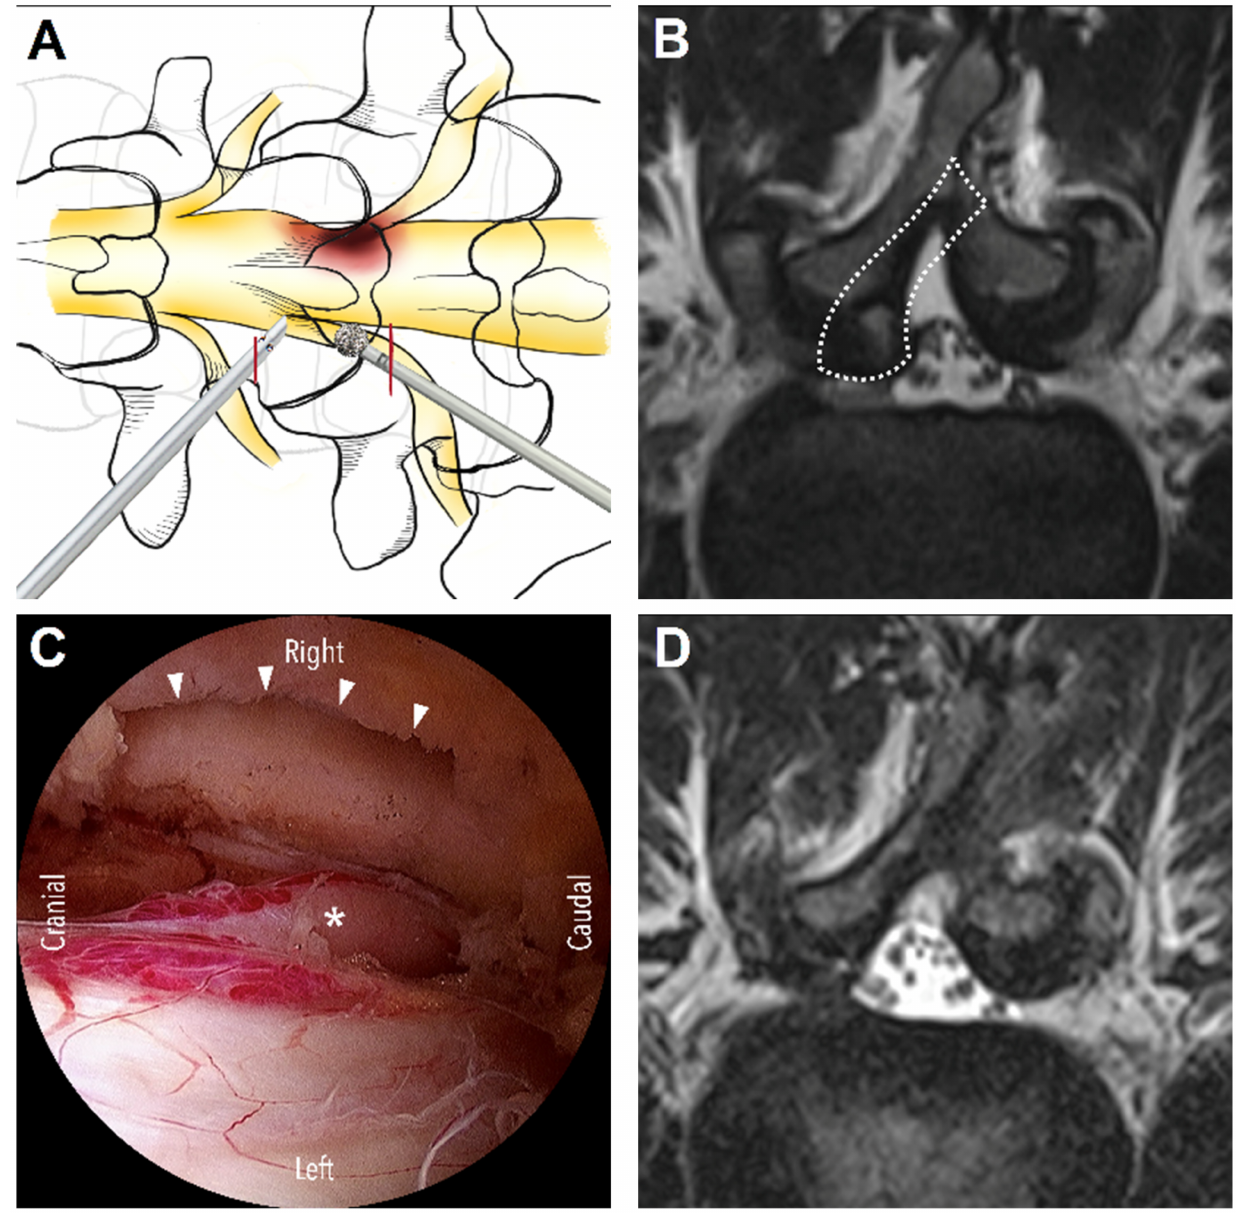
Figure 2. The contralateral approach. ( A ) The schematic diagram illustrates the skin incisions (red lines) and initial target area of decompression from the left side: the junction of spinous process and lamina. ( B ) Pre-operative MRI shows isolated lateral recess stenosis and contralateral decompression via an opposite interlaminar window (dashed line area). ( C ) The endoscopic view demonstrates the facet joint viewed from inside the spinal canal (white arrow heads), decompression of the lateral recesses, and the traversing nerve root (white asterisk). ( D ) Post-operative MRI shows adequate decompression of the lateral recess with complete preservation of the ipsilateral facet joints and minimal soft tissue